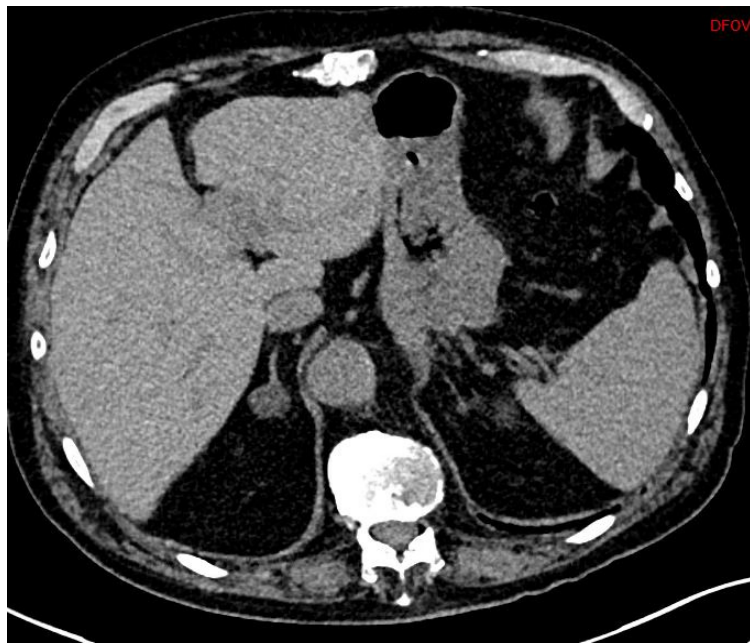
Figure 1. Abdominal CT (DFOV 80 × 35mm): Adrenal adenoma, right adrenal